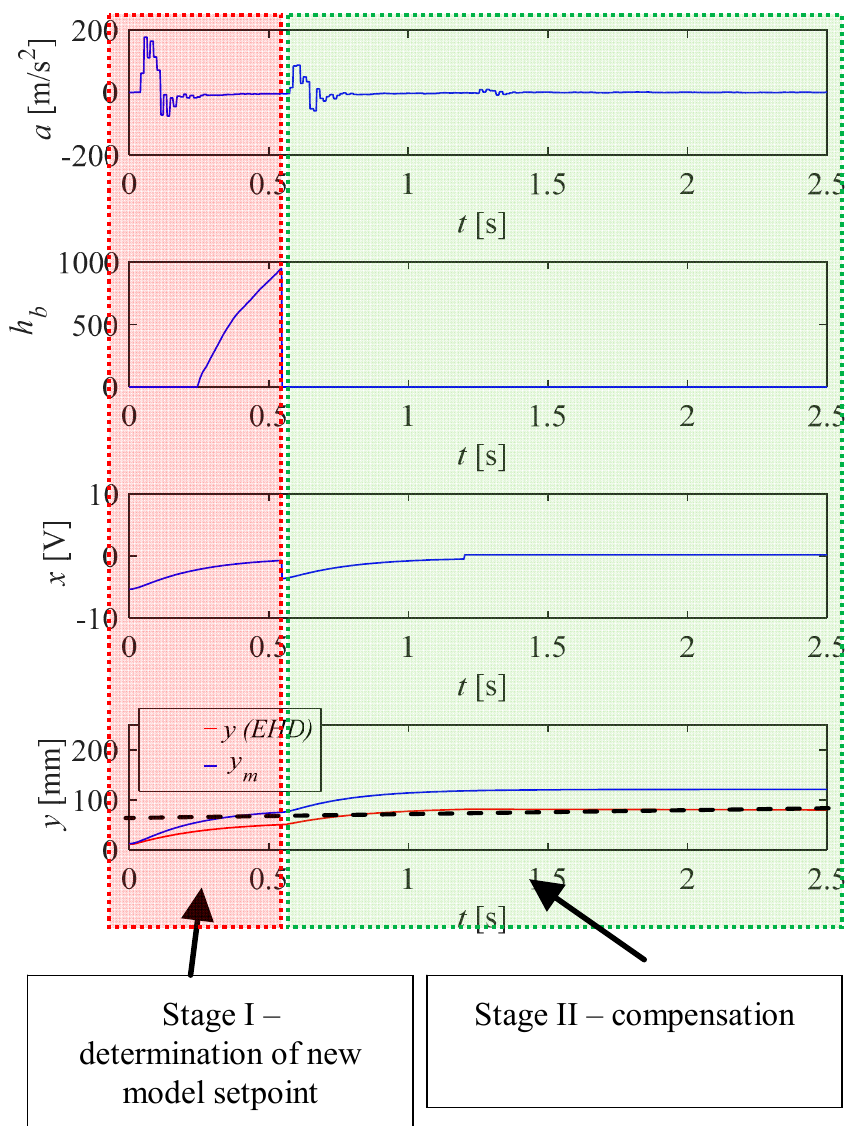
Figure 3. Graph showing the operation of the control algorithm, divided into two phases of move- ment.